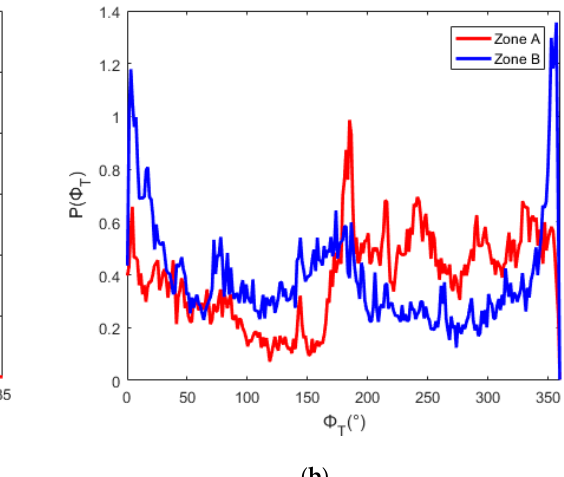
Figure 8. The PDFs of slope and aspect in zone A and B: ( a ) the PDFs of slope, ( b ) the PDFs of aspect.